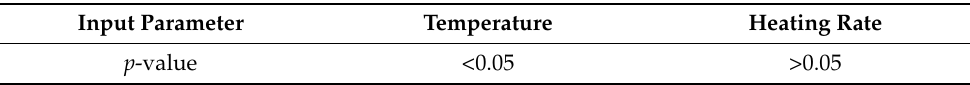
Table 6. The p -values of the input